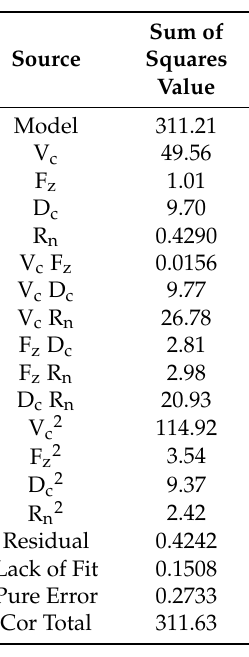
Table 5. ANOVA table of